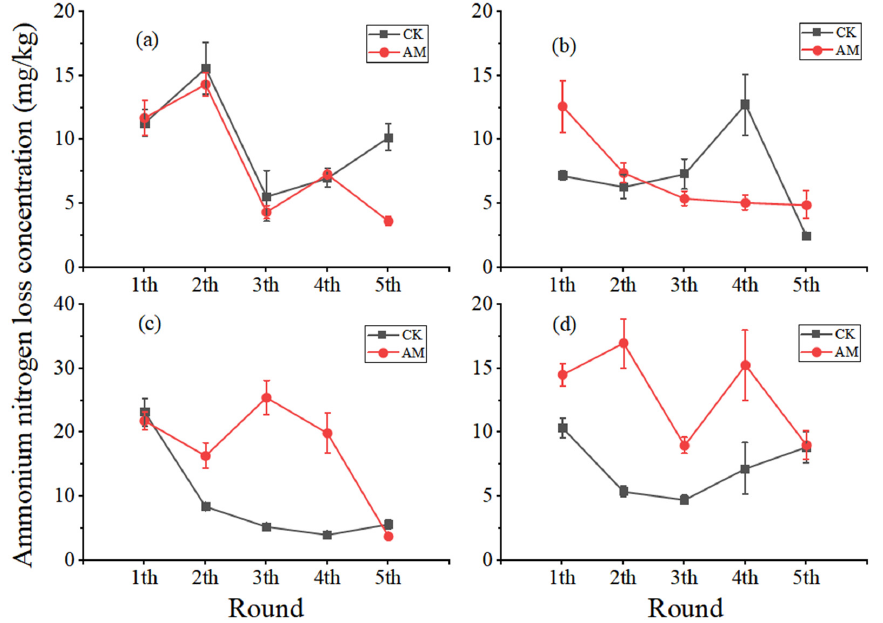
Figure 4. Variation in sediment ammonium nitrogen loss concentration in different soil troughs under simulated scouring in ( a ) Cynodon dactylon , ( b ) Lotus corniculatus , ( c ) Zoysia japonica , and ( d ) Astragalus sinicus . Error bars represent ± standard errors.